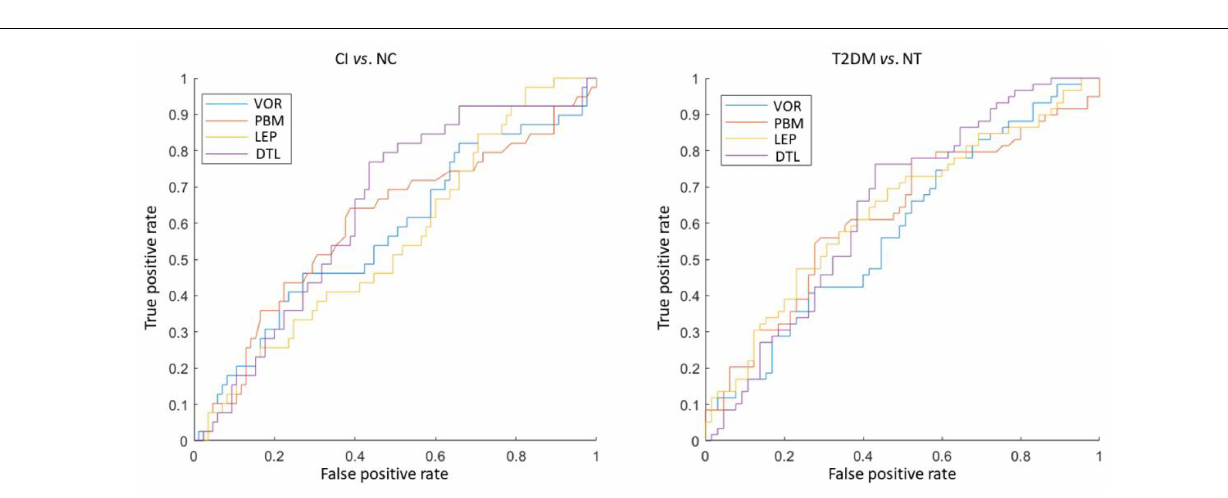
FIGURE 3 | The ROC curve of four different feature extraction methods in both discriminating the cognitive impairment (CI) subjects from normal cognition (NC) subjects (left), as well as type 2 diabetes mellitus (T2DM) subjects from individuals without T2DM (NT)